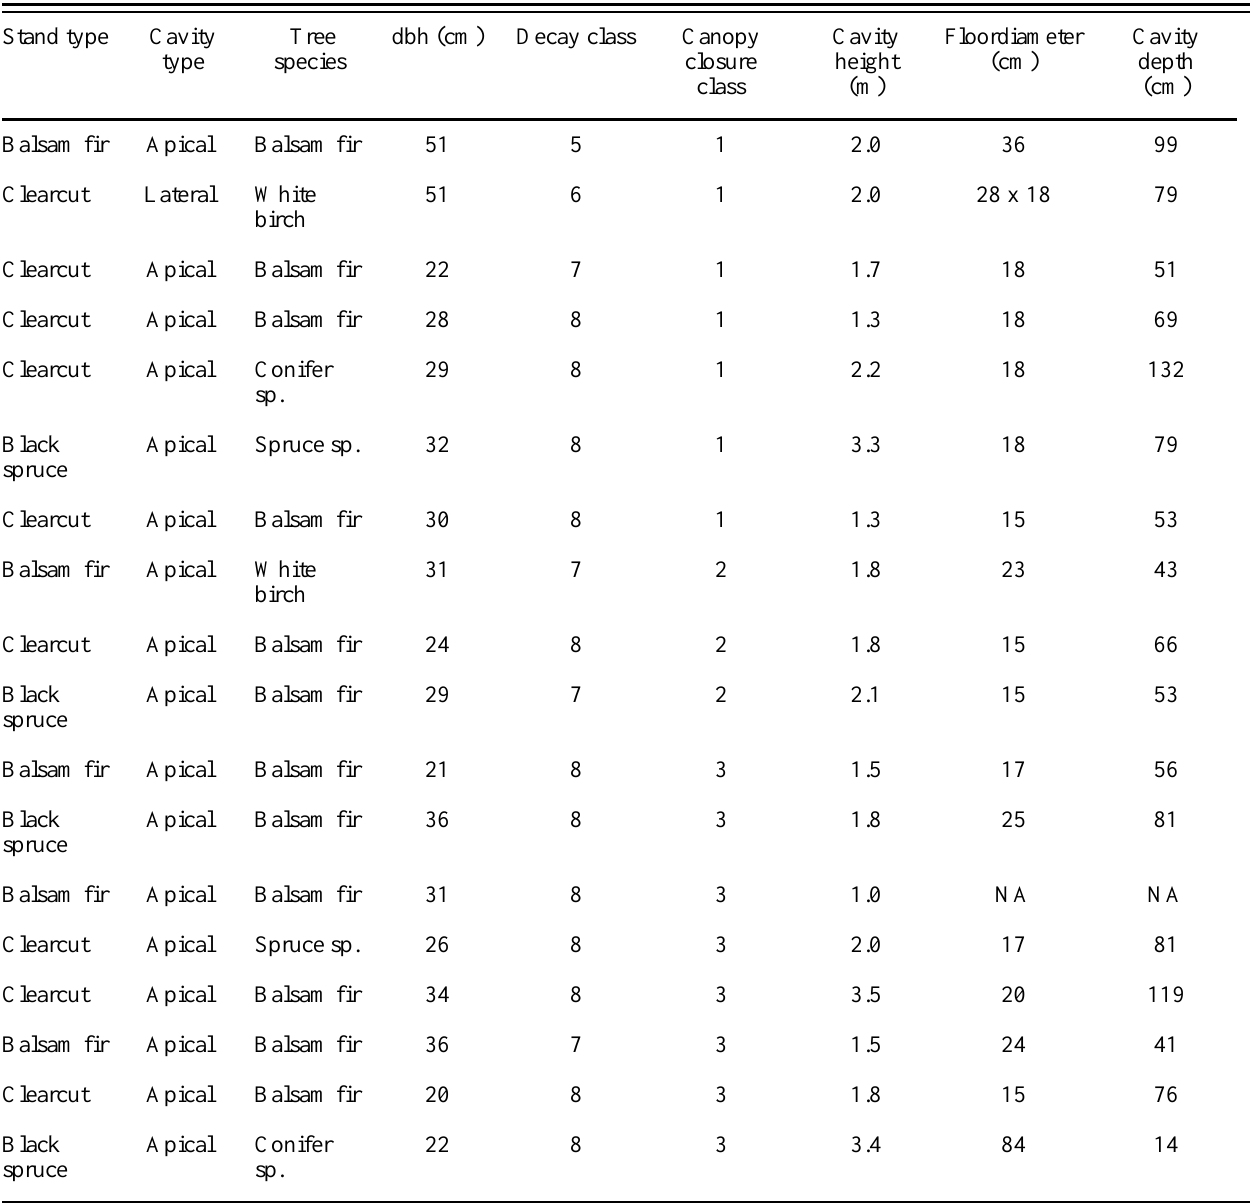
Table 2 . Stand type and physical characteristics of cavities considered suitable for the breeding of Barrow’s Goldeneyes ( Bucephala islandica ) found in 43 ha of linear transects located in unharvested (17.2 ha), remnant (5.8 ha), and harvested forests (20 ha) of balsam fir ( Abies balsamea ) and black spruce ( Picea mariana ) in the Chauvin and Martin-Valin controlled wildlife harvesting zones, Quebec, Canada, 2004– 2005; “dbh” stands for diameter at breast height. Entrance dimensions are not included in this table because only one lateral cavity was considered suitable and its entrance dimensions met the established criteria. Refer to the Methods section for details on classifying decay and canopy closure. NA means that measurements could not be taken on cavity 13, but the cavity was visually